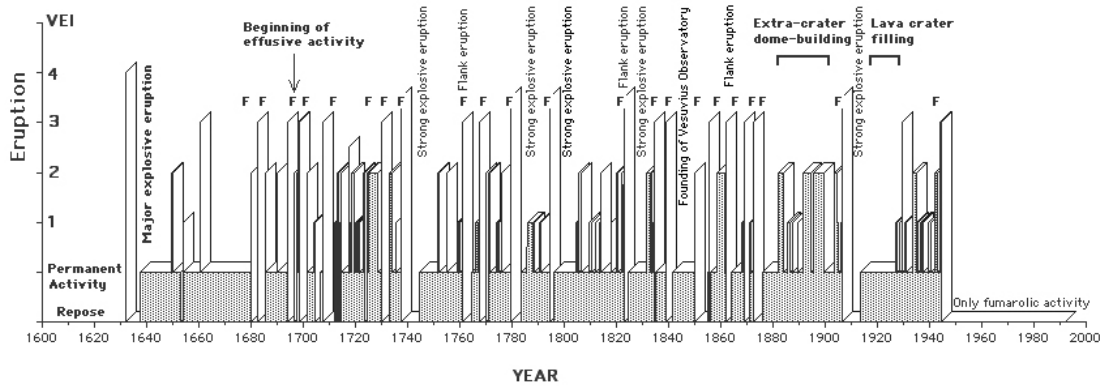
Figure 1. Scheme of the eruptive activity between 1631 and 1944. The horizontal bars indicate periods of permanent activity. The height of the vertical bars indicate the VEI of the eruptions; F indicates the major Violent Strombolian Eruptions eventually causing a small collapse of the “crater” and a subsequent short quiescence (modified after Scandone et al.